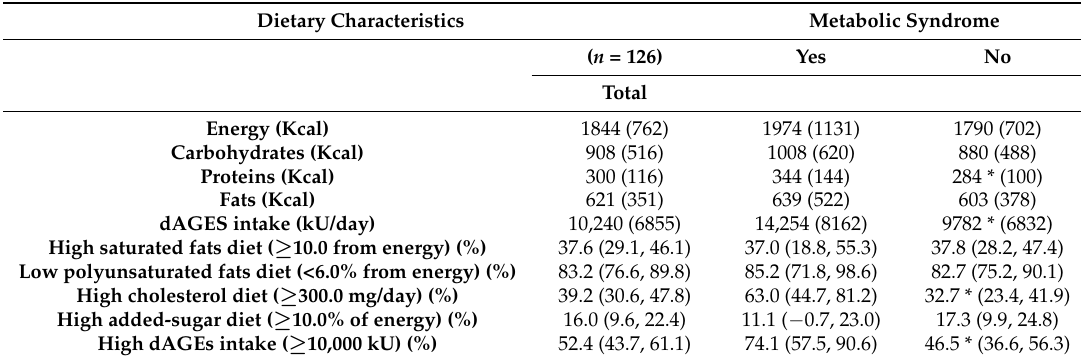
Table 2. Diet characteristics and dAGEs intake by metabolic syndrome